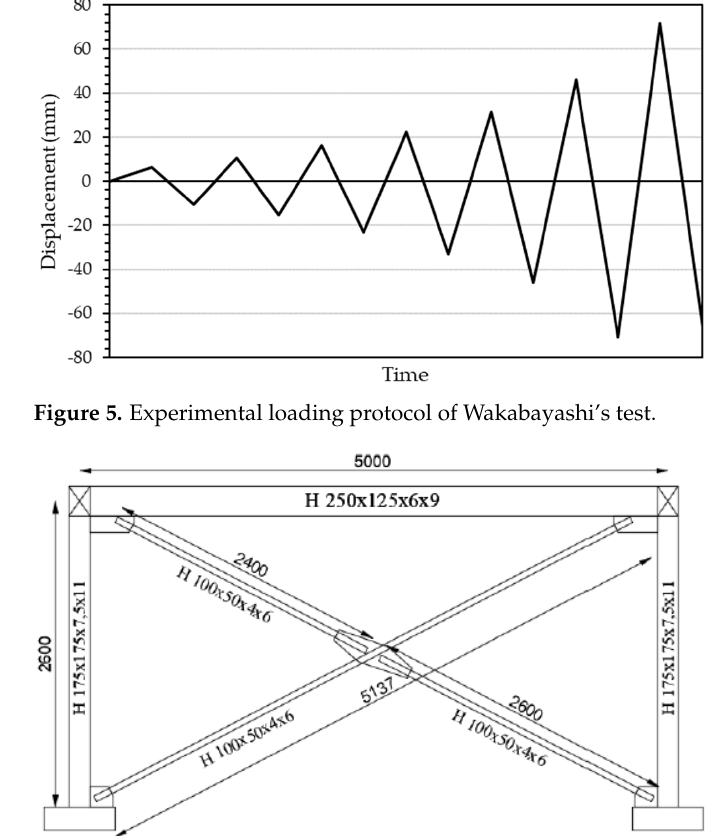
Figure 6. Representation of the X-CBF used in Wakabayashi’s test (measurements in mm). Some like “x” means “×”.